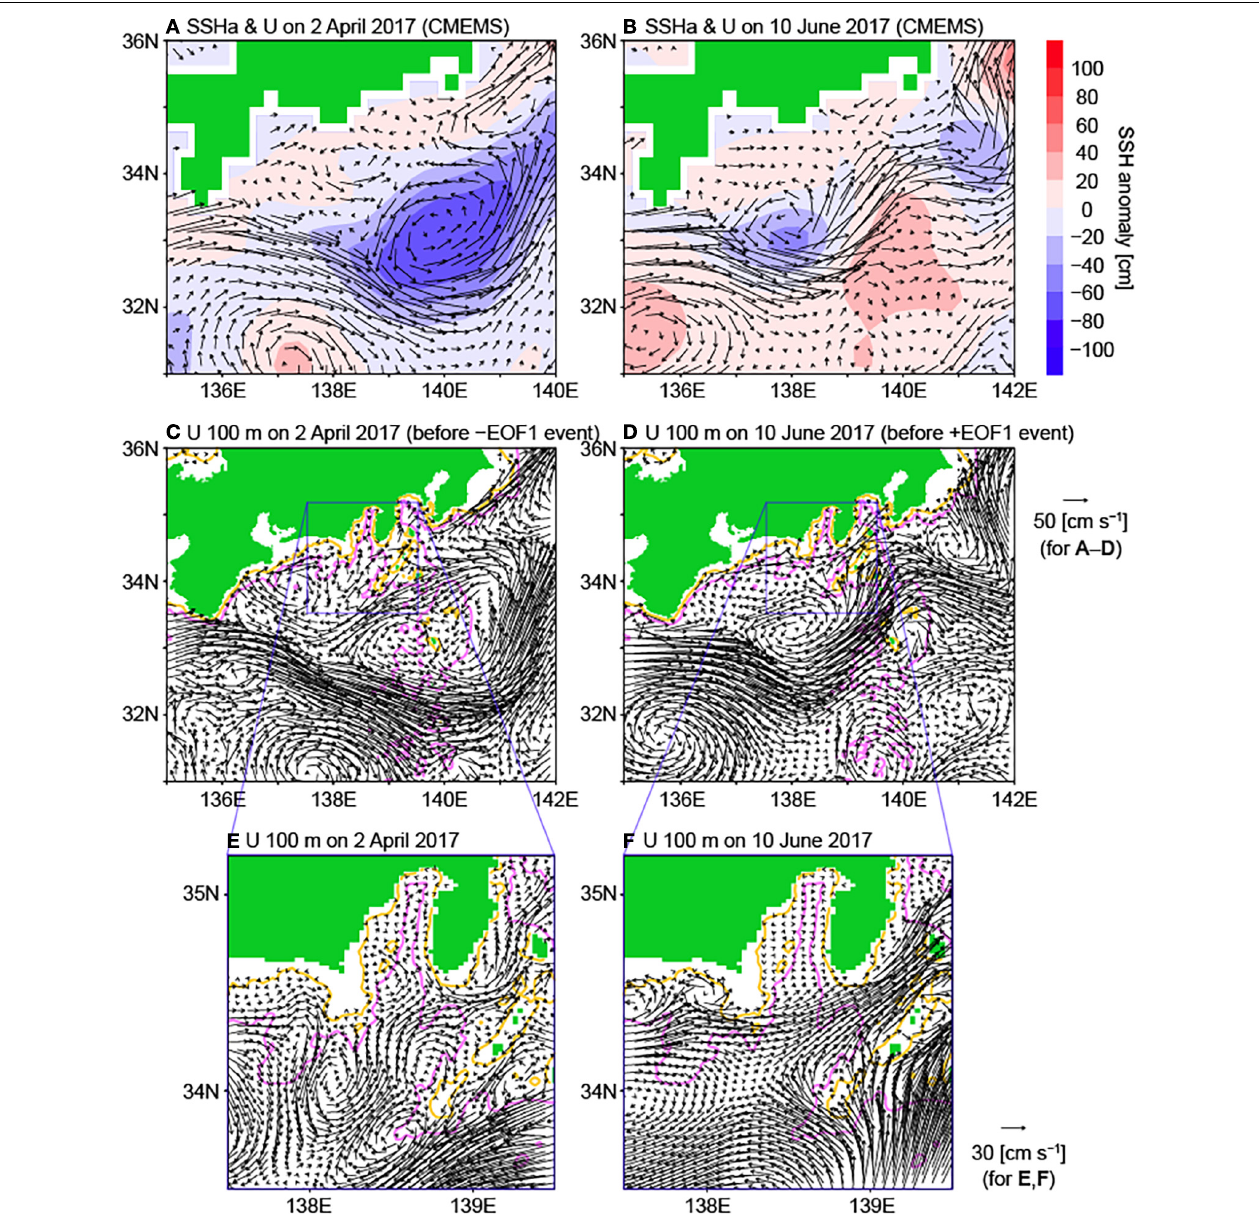
FIGURE 7 | (A,B) Distributions of SSH anomalies and surface velocities from the satellite altimeter product (CMEMS) before the negative (A) and positive (B) EOF1 events (2 April 2017 and 10 June 2017, respectively). (C,D) Distributions of horizontal velocities at 100 m depth on the same days as (A,B) from the simulation product, respectively. Yellow and pink lines indicate 200 and 1,000 m depth isolines (see Figure 2A ). (E,F) Same as (C,D) but expanded near Suruga